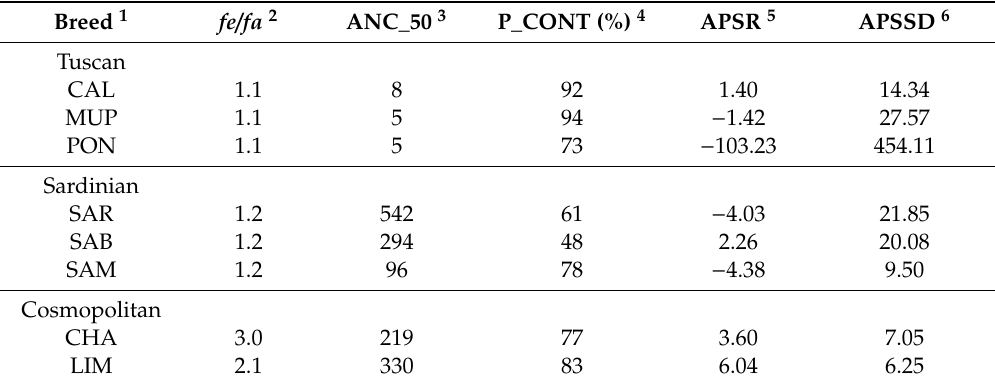
Table 5. Population parameters for each breed.